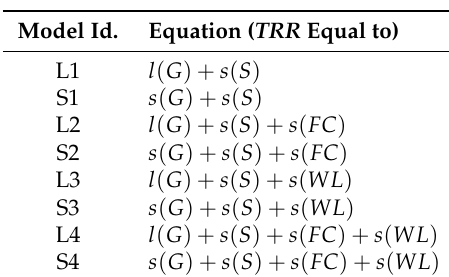
Table 1. GAMM models